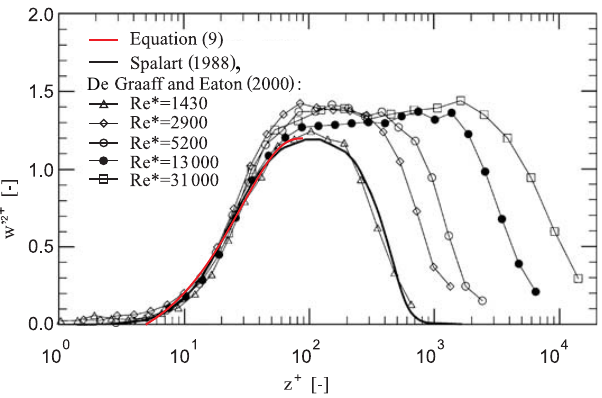
Figure 2. Equation (9) compared to universal scaling of the verti- cal turbulent velocity in the near-boundary region in DNS (Spalart, 1988) and physical experiments (De Graaff and Eaton, 2000). Equa- tion (9) is plotted as a red line. Modified after De Graaff and Eaton